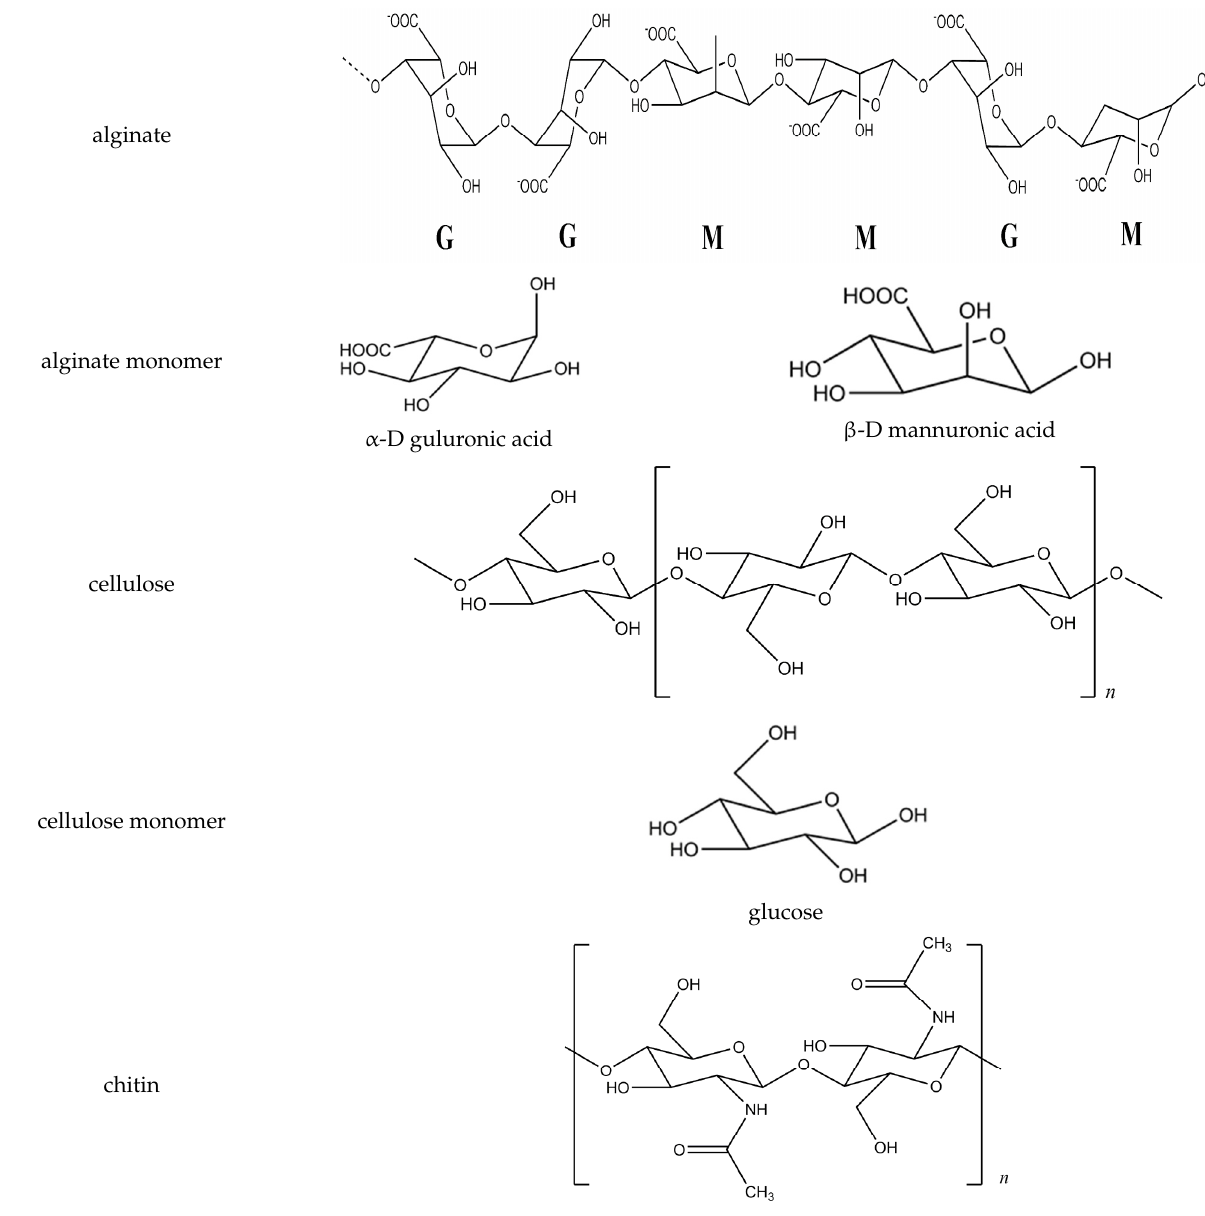
Figure 1. A pictorial depiction of several natural, renewable biopolymers categorized according to their source [55].